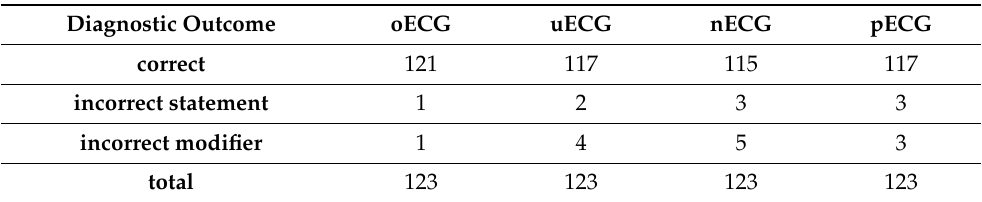
Table 9. Correctness of verbose diagnostic outcomes of original, uniformized, non-uniform, and pseudo-non-uniform ECGs (123 CSE